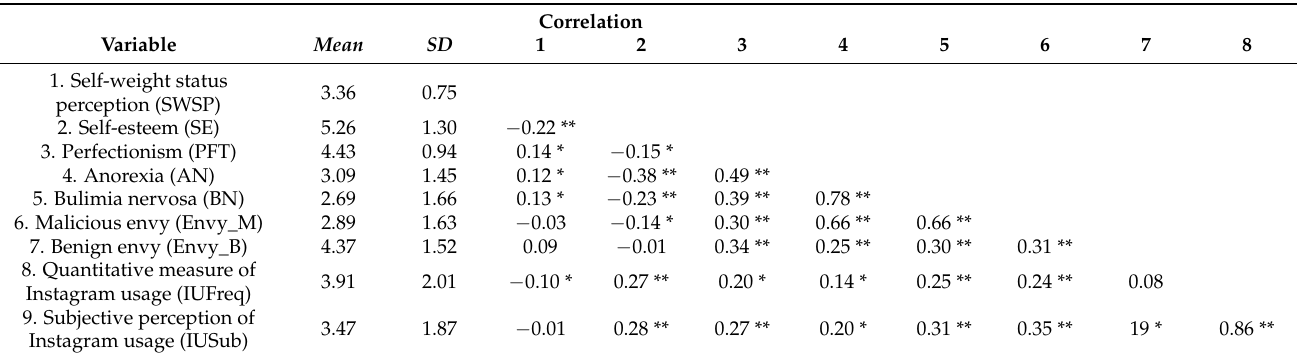
Table 4. Study 2: Means, standard deviations (SDs), and correlations (Pearson’s parametric correla- tion) of variables ( n =